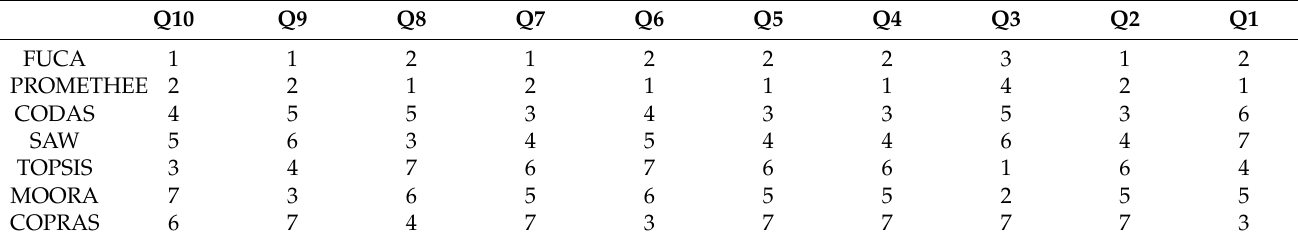
Table 8. Performance Ranking of MCDM Methods according to SD.